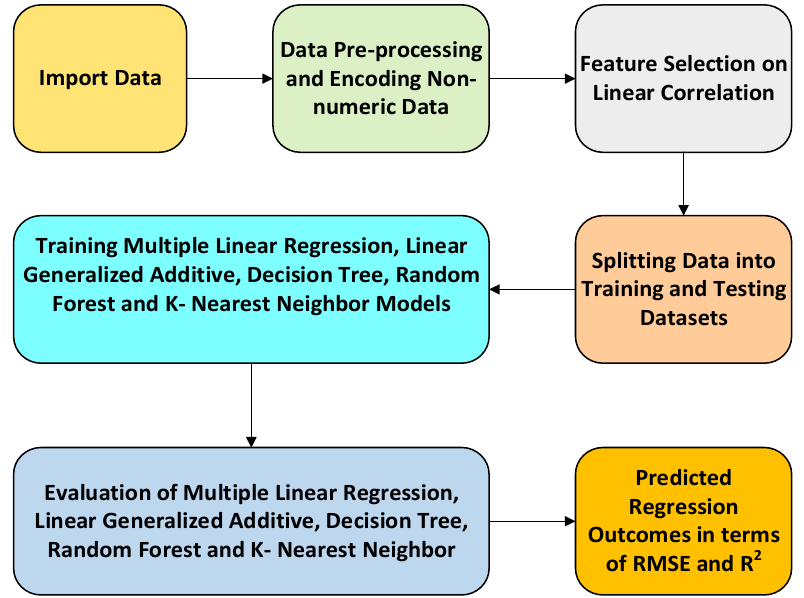
Figure 1. Overall pipeline for the pre-processing and training of the Medicare dataset.